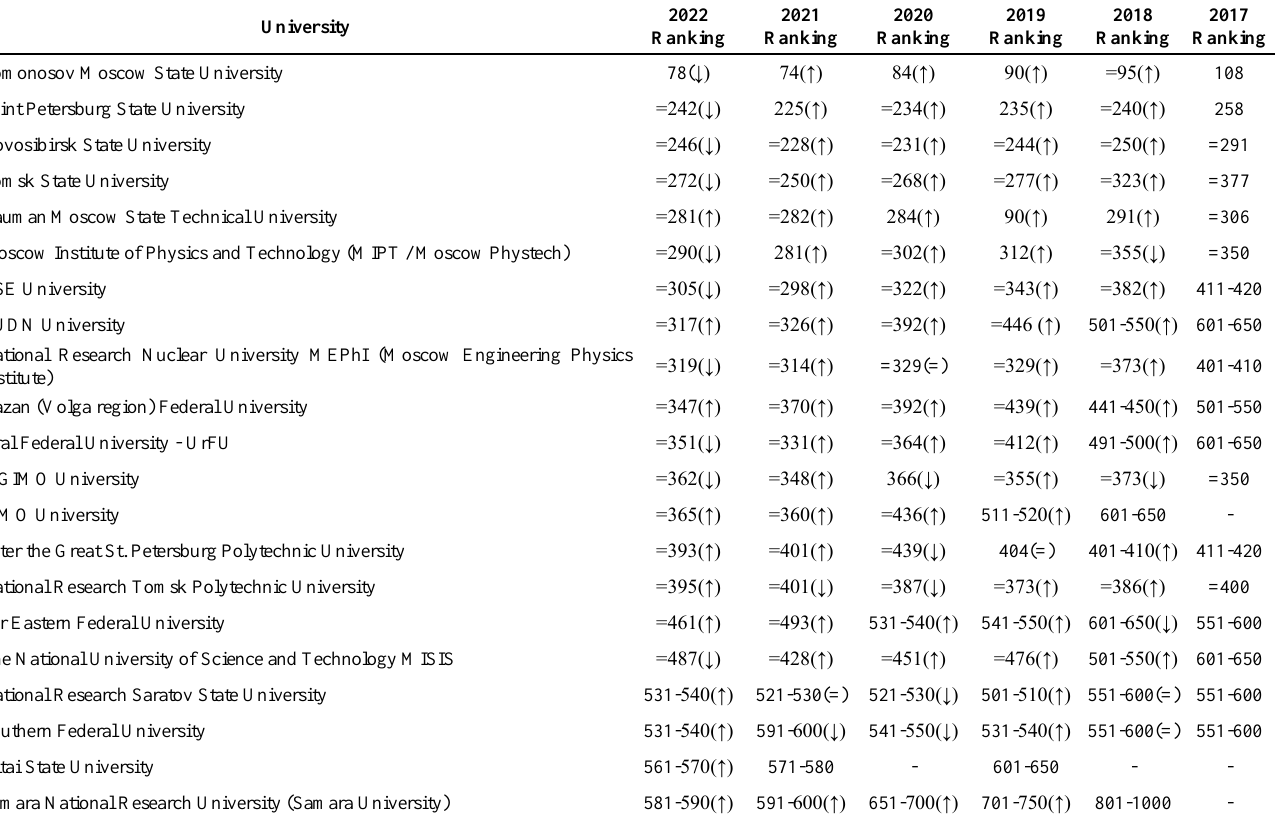
Table 1. Positions of Russian universities in 2017-2022 QS WUR